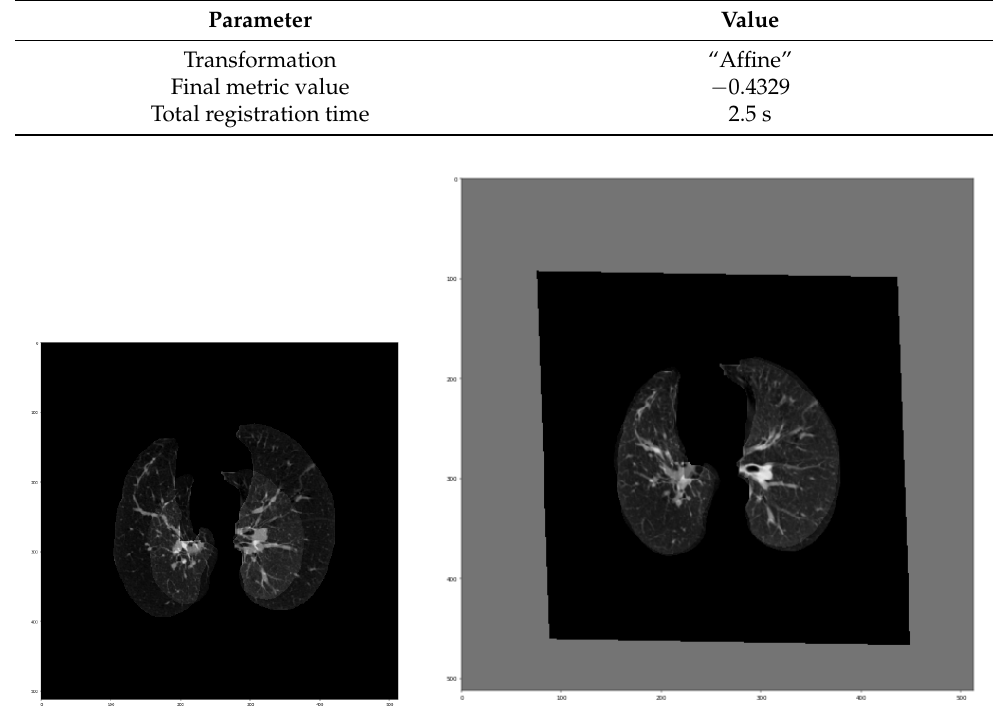
Table 6. Result of one slice affine registration using SimpleITK.